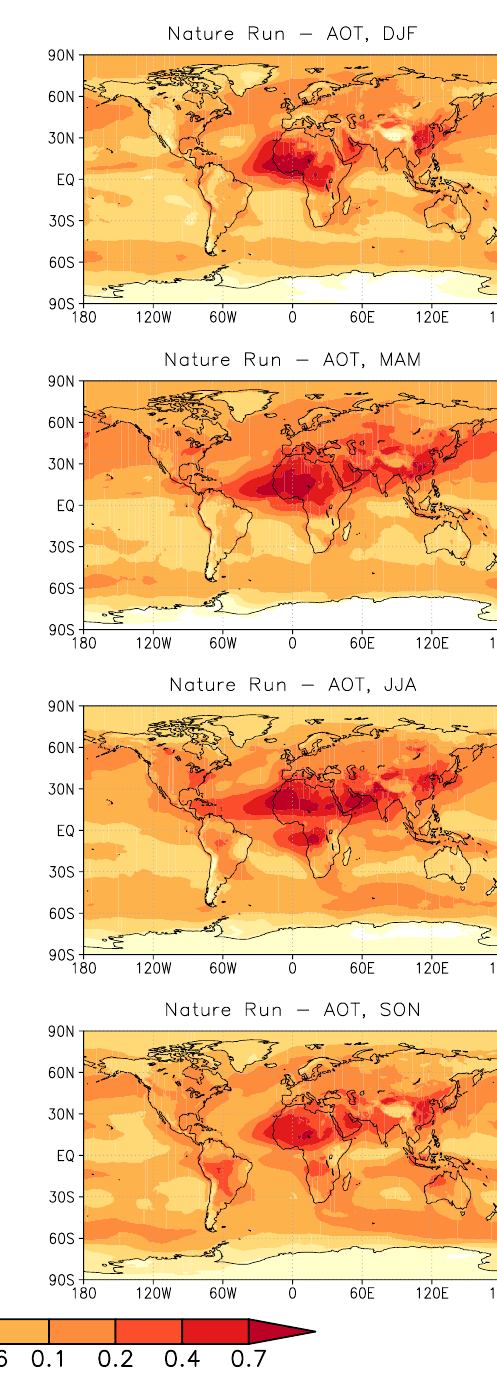
Figure 3. 2006 seasonal mean 550 nm AOD from the MERRAero aerosol reanalysis (left column) and Figure 3: Seasonal-mean AOT from the MERRA aerosol reanalysis (left column panels) the G5NR (right column). Time-averaged values for DJF, MAM, JJA, and SON are organized from top ERO to and the Nature Run simulation (right column panels). Time-averaged values for DJF, MAM, JJA and SON in 2006 are organized in rows from top to bottom.